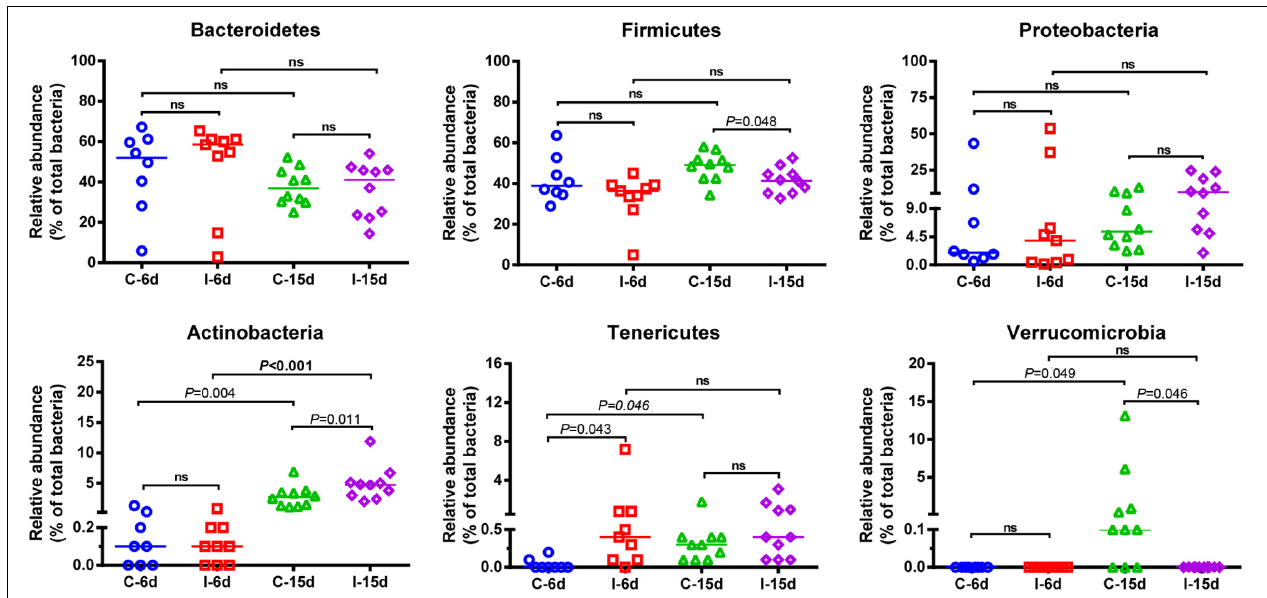
FIGURE 2 | Comparison of the relative abundance of the Bacteroidetes, Firmicutes, Proteobacteria, Actinobactria, Tenericutes, and Verrucomicrobia phyla within groups. Values are shown as a fraction of the total bacteria detected within each samples. Lines represent the median value. Statistical tests were performed using post hoc ANOVA and ns indicated no significant